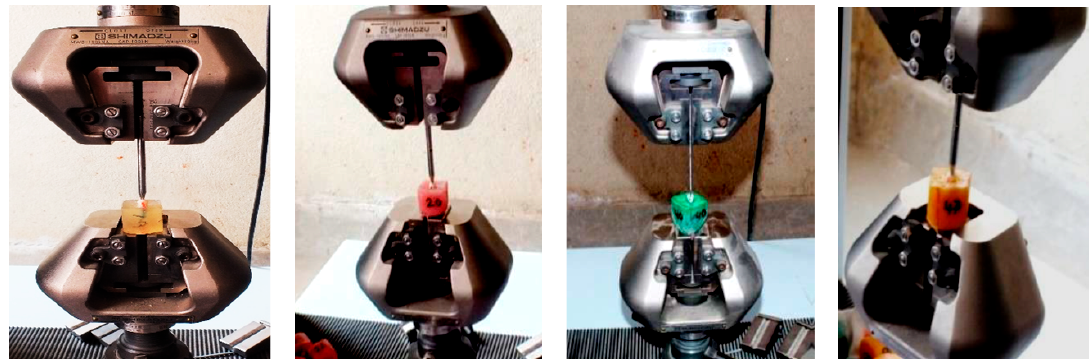
Figure 1. Load testing of the sample (Groups I, II, III and IV, respectively).